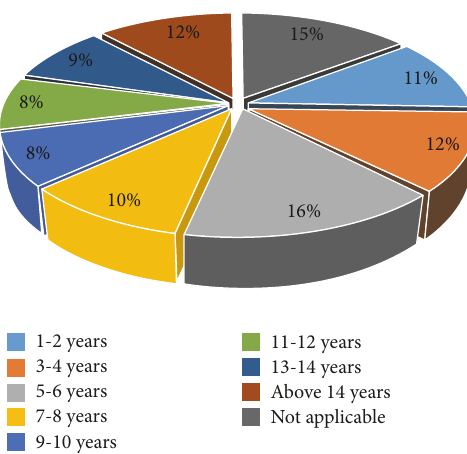
Figure 3: Number of years of involvement in alternative income